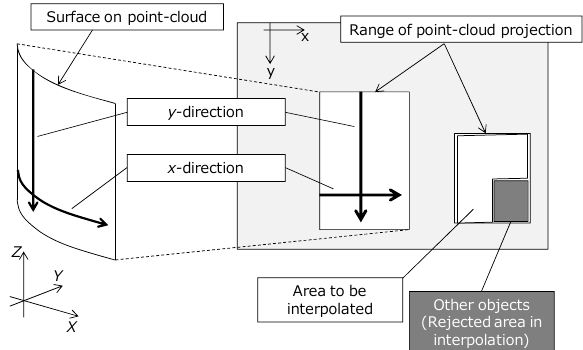
Figure 4. Point-cloud interpolation with a rectangular template in a range